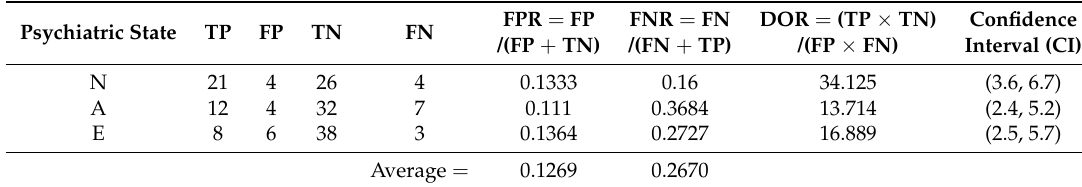
Table 3. Type I and Type II error rate, DOR and CI of the predicted psychiatric